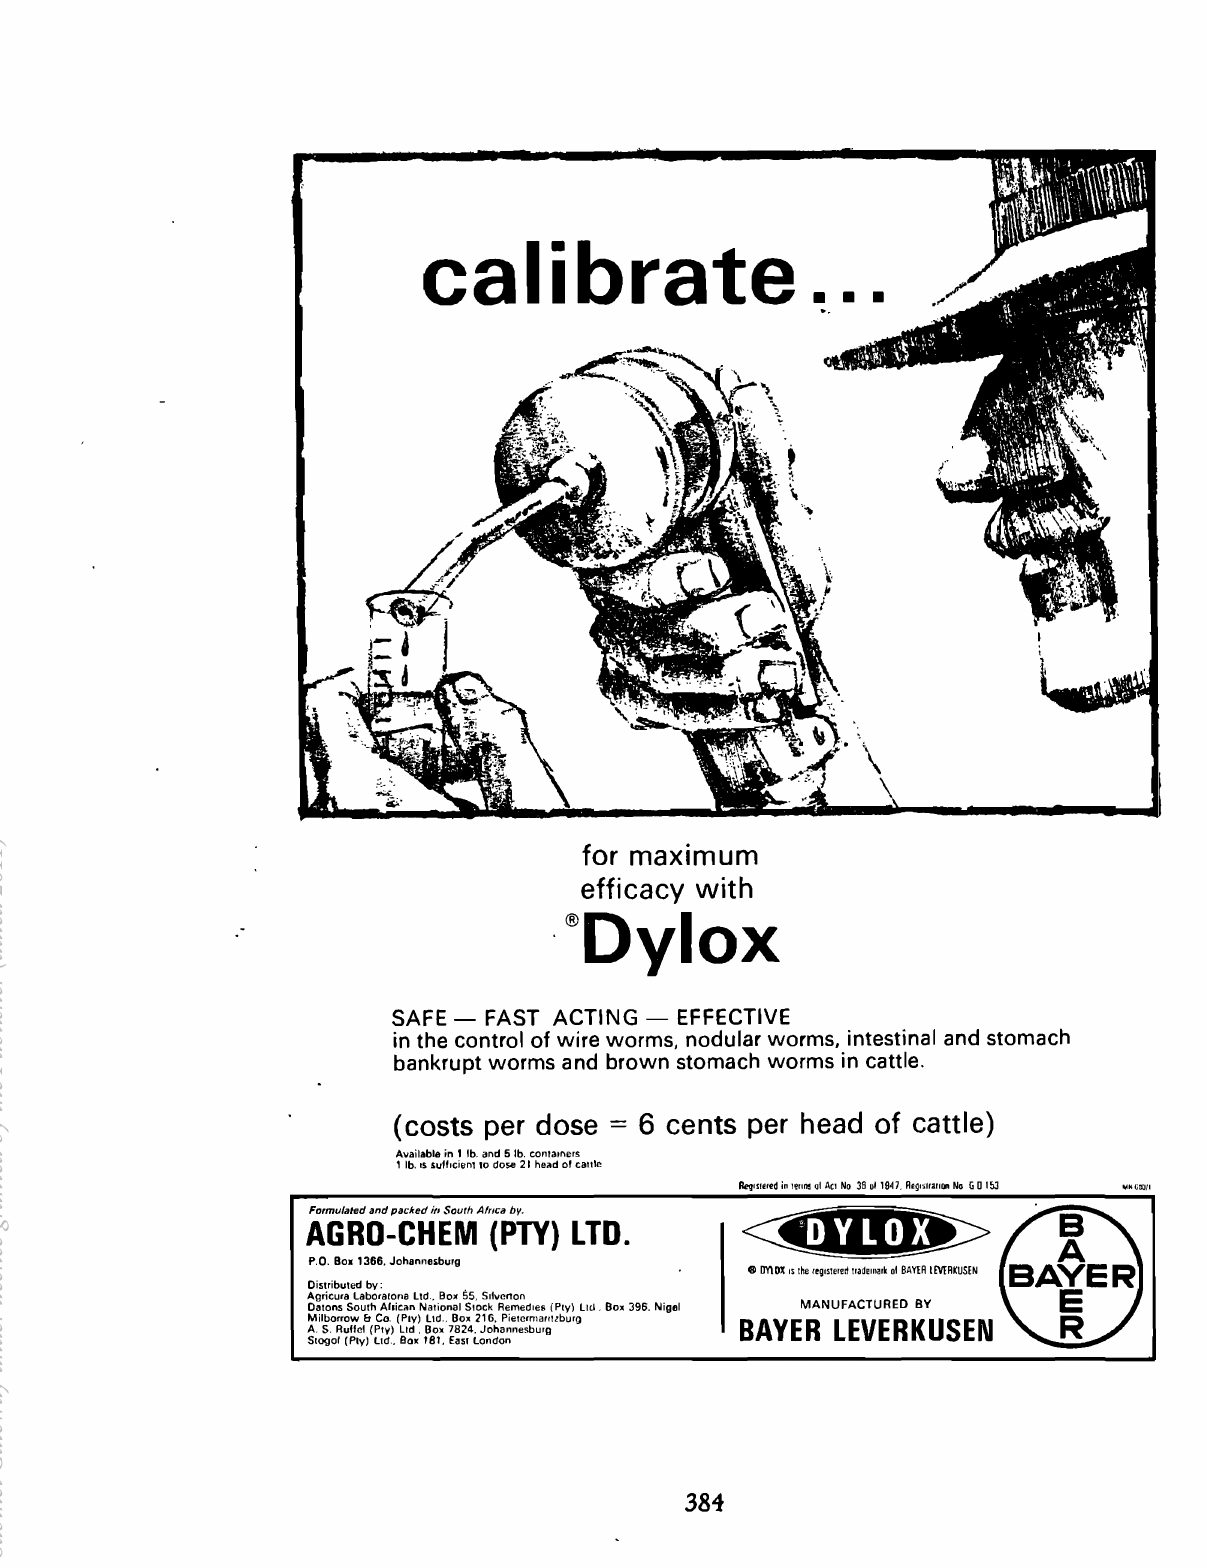
for maximum efficacy with '®Dylox SAFE - FAST ACTING - EFFECTIVE in the control of wire worms, nodular worms, intestinal and stomach bankrupt worms and brown stomach worms in cattle, (costs per dose = 6 cents per head of